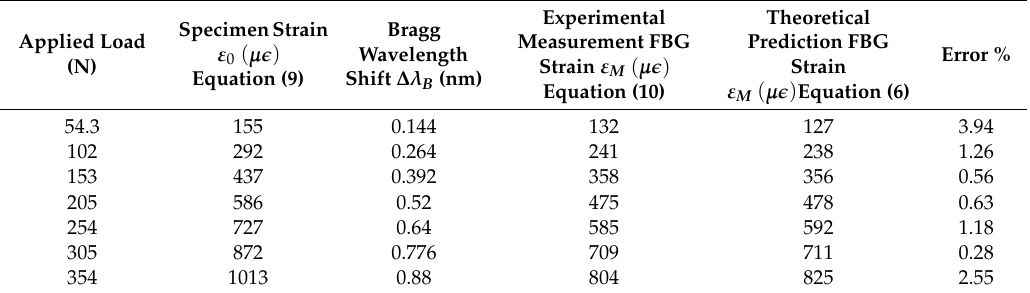
Table 3. Strain transferred from the specimen to the bonded FBG sensor in the three-point bending tests. Applied Load